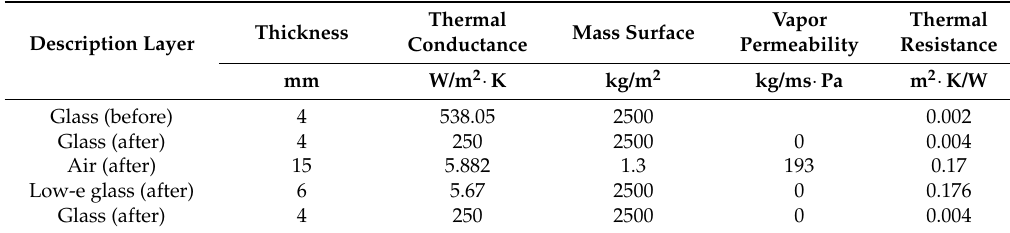
Table 7. MiSe fixtures stratigraphy before (single glasses) and after (low-e glasses) intervention.